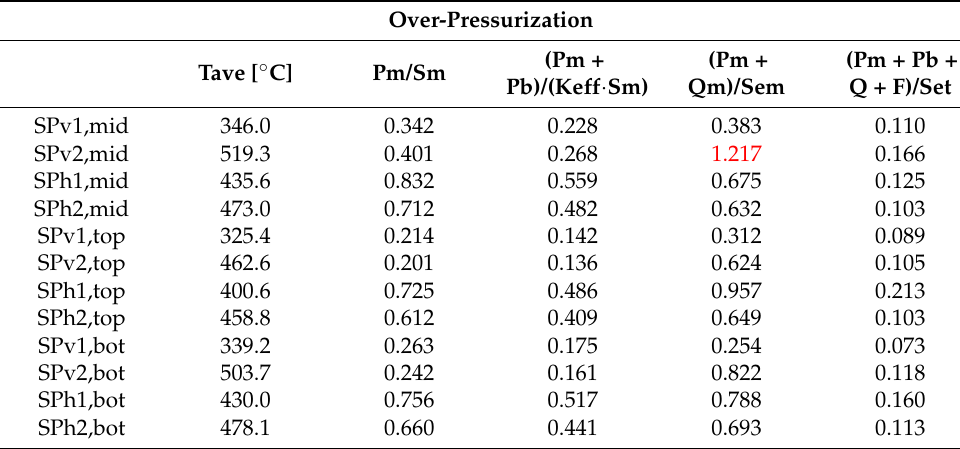
Table 7. Verification of RCC-MRx criteria under OP loading